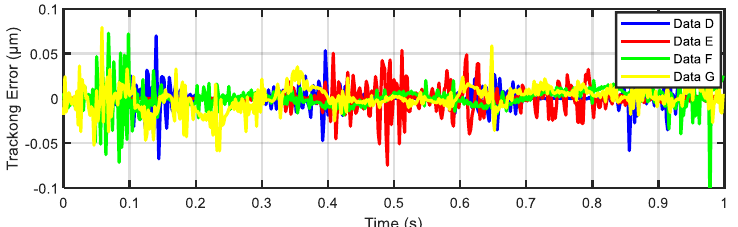
Figure 11. The error level between the actual output of the considered piezoelectric actuator and estimated output of the proposed model for test data D, E, F, and G.